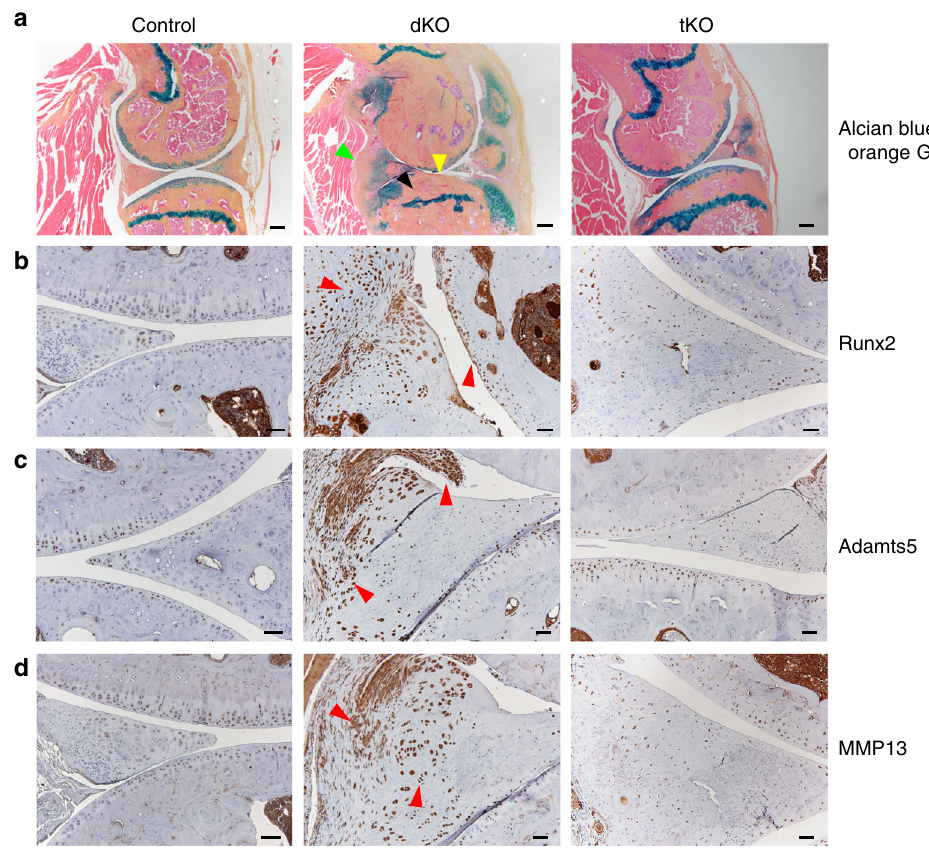
Fig. 7 Runx2 insuf fi ciency mitigates OA phenotype in dKO mice. a Representative histology images of 9-month-old tKO ( miR-204 fl ox / fl ox ; miR-211 fl ox / fl ox ; Runx2 + /flox ; Prx1-Cre ) mice compared with dKO ( miR-204 fl ox / fl ox ; miR-211 fl ox / fl ox ; Prx1-Cre ) and control ( miR-204 fl ox / fl ox ; miR-211 fl ox / fl ox ) mice. Yellow arrowheads, articular cartilage degradation; green arrowhead, synovial hyperplasia; black arrowhead, subchondral sclerosis. n = 5. Scale bars, 200 μ m. b – d IHC results of Runx2 ( b ), Adamts5 ( c ), and MMP13 ( d ) expression in the control, dKO and tKO mice. Red arrowheads, Runx2-, Adamts5-, or MMP13- positive cells. Scale bar, 50 μ